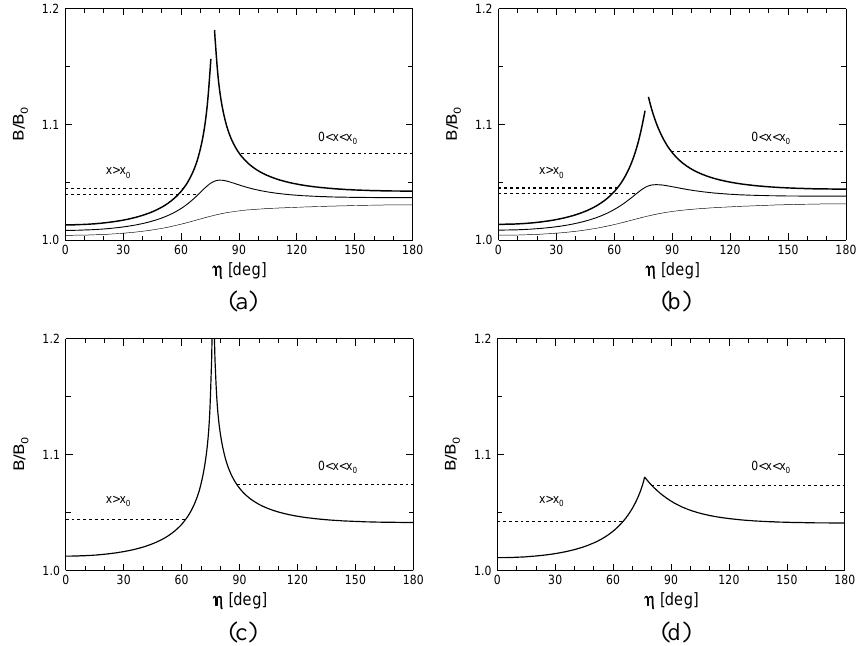
Figure 4. B profiles along magnetic field lines for y 0 = x 0 / 2 (anti-parallel case). Top: three field lines when (a) y 1 = y 0 (taken from Romashets and Vandas, 2012) or (b) y 1 = 0 . 9 y 0 . Bottom panels: (c, d) supplements (a, b) , respectively, with magnetic field lines crossing an edge of a sheet. The dashed lines show mirroring condition for particles with initial pitch angle 80 ◦ ; their thickness corresponds to associated magnetic field